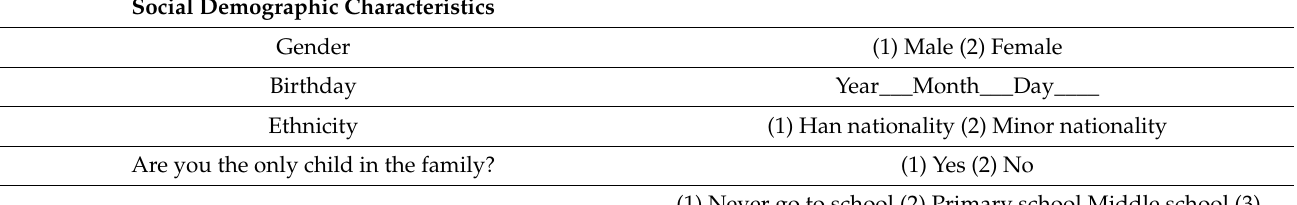
Table 1. The questionnaire used in the